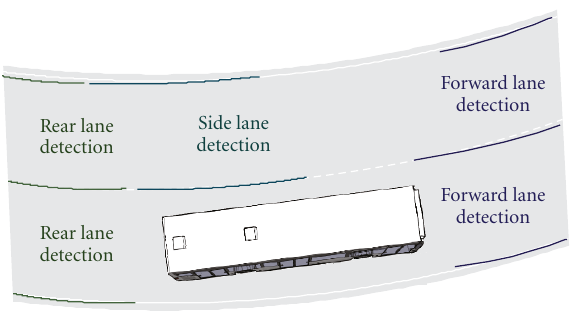
Figure 4: Rear, side, and forward lane